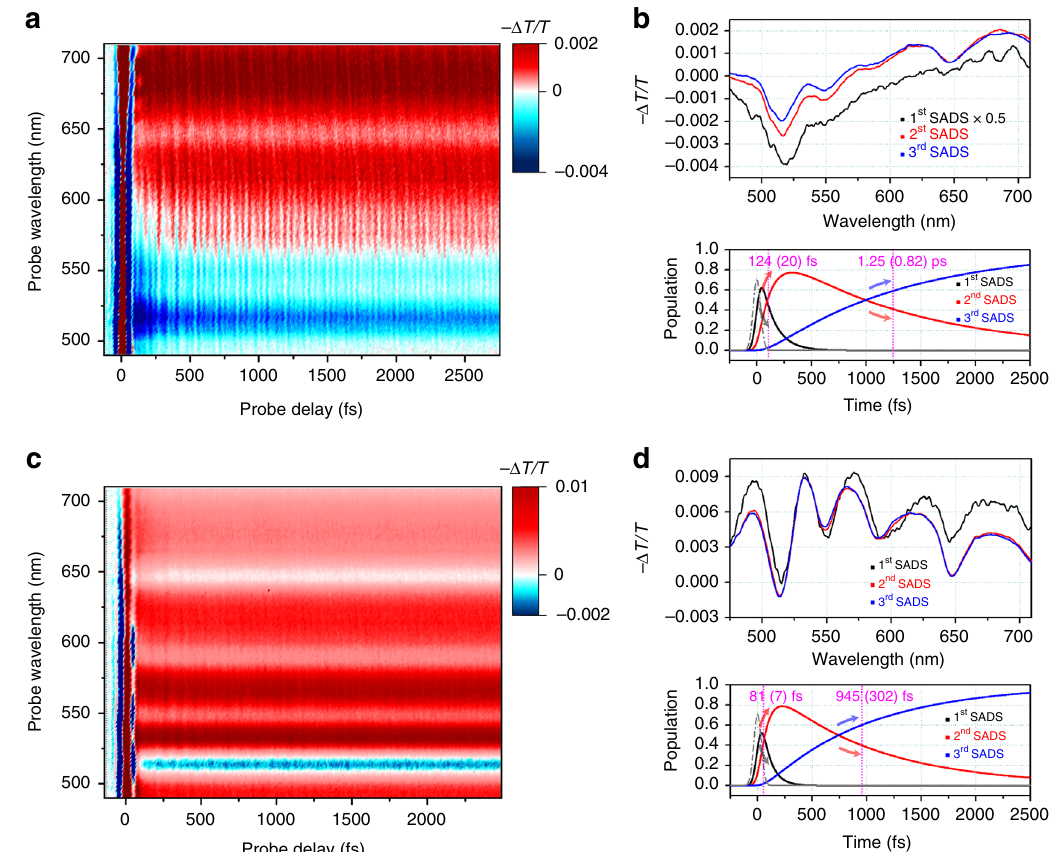
Fig. 2 Two-dimensional transient absorption (TA) spectra. a Broadband TA spectra of COFs. b The upper panel shows the species-associated difference spectra (SADS) of COFs determined from the global kinetic analysis of TA spectra based on the sequential kinetics with the time constant of 124 fs and 1.25 ps. The amplitude of the fi rst SADS was scaled for clear comparison with other SADS. The lower panel shows time-dependent population change of the SADS. The instrumental response function (dashed lines) is plotted together. c TA spectra of free-base porphyrin. d The upper panel shows the SADS of free-base porphyrin. The lower panel shows time-dependent population change of the